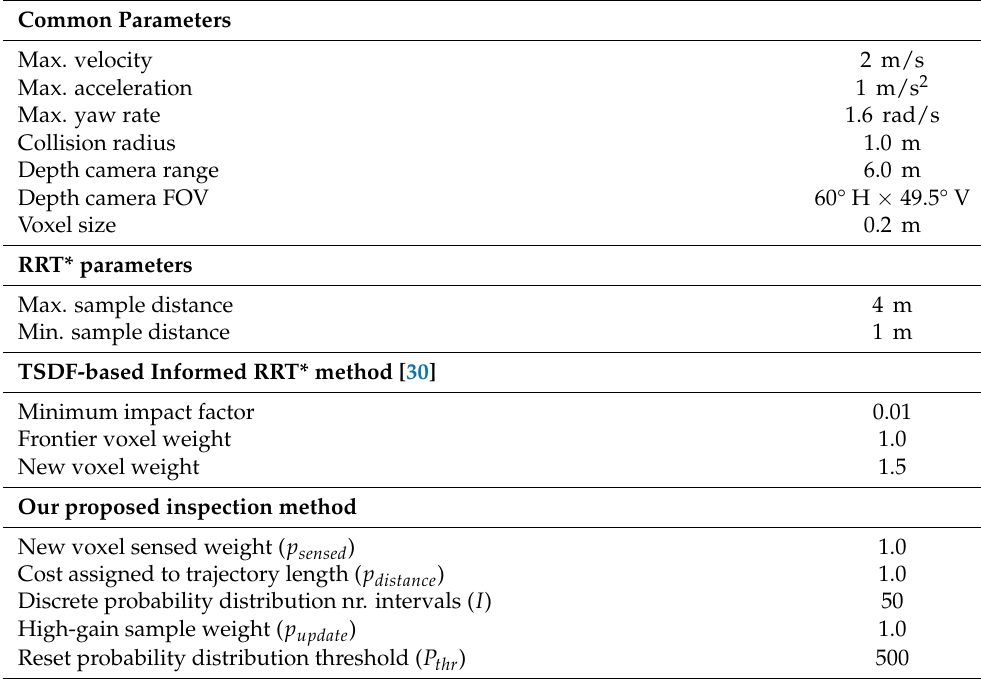
Table 3. Parameters used throughout the simulation experiments.